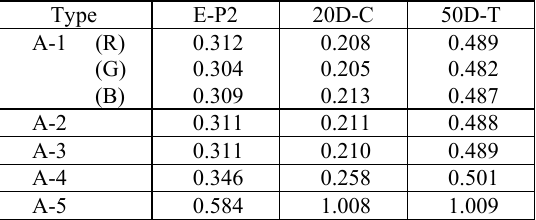
Table 4. RMSE in the camera calibration (Unit: